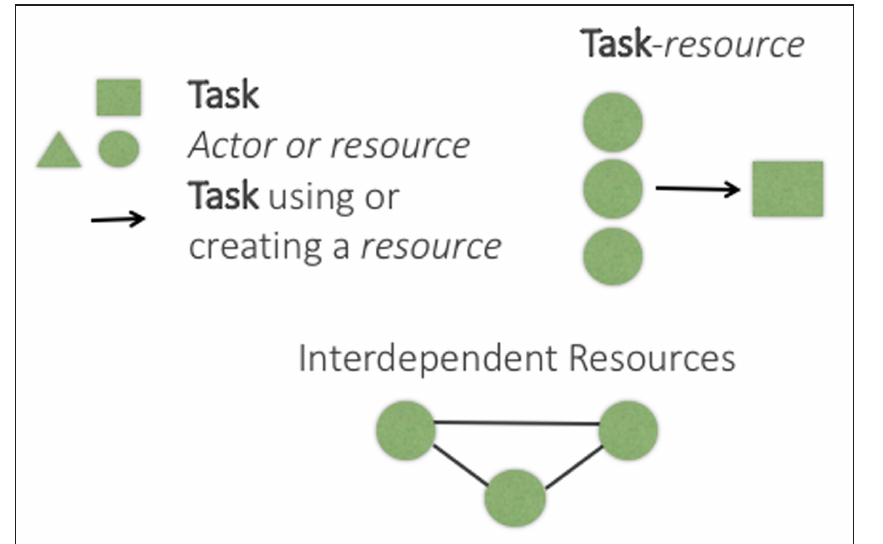
Figure 1: Tasks (squares) and resources (triangles) or actors (circles) (upper left); tasks create/use resources creating a task/resource assignment problem (upper right) and dependencies among interdependent resources